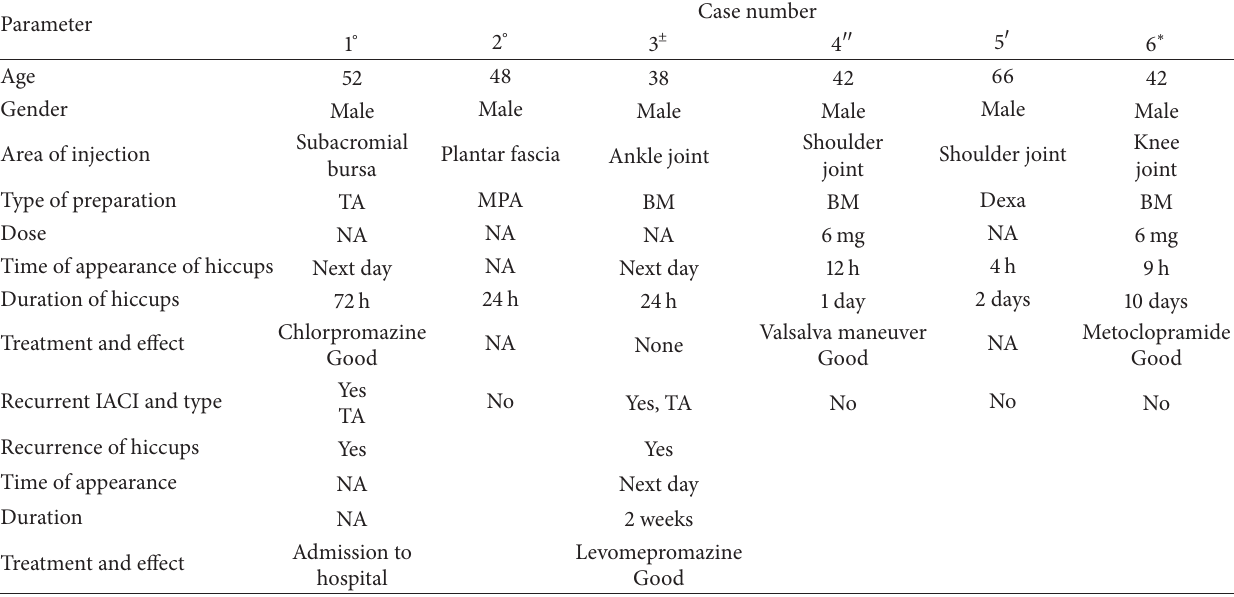
Table 1: Demographic and clinical parameters of the